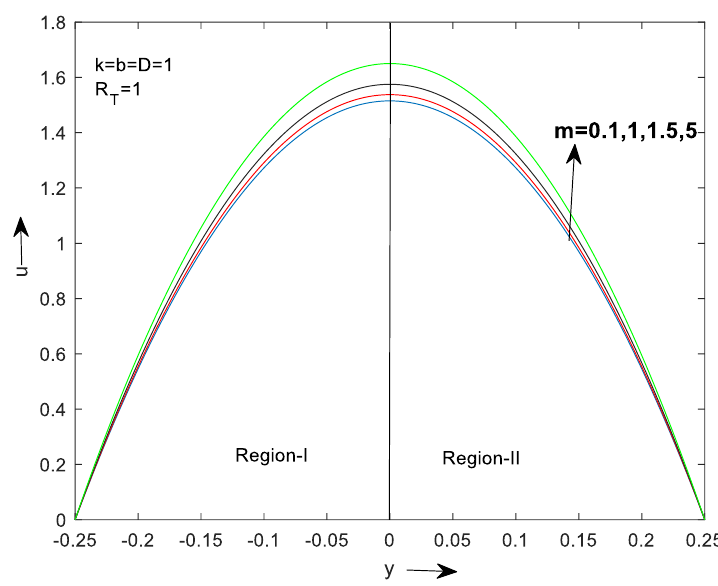
Fig. 5a. Velocity profile for different values of m.